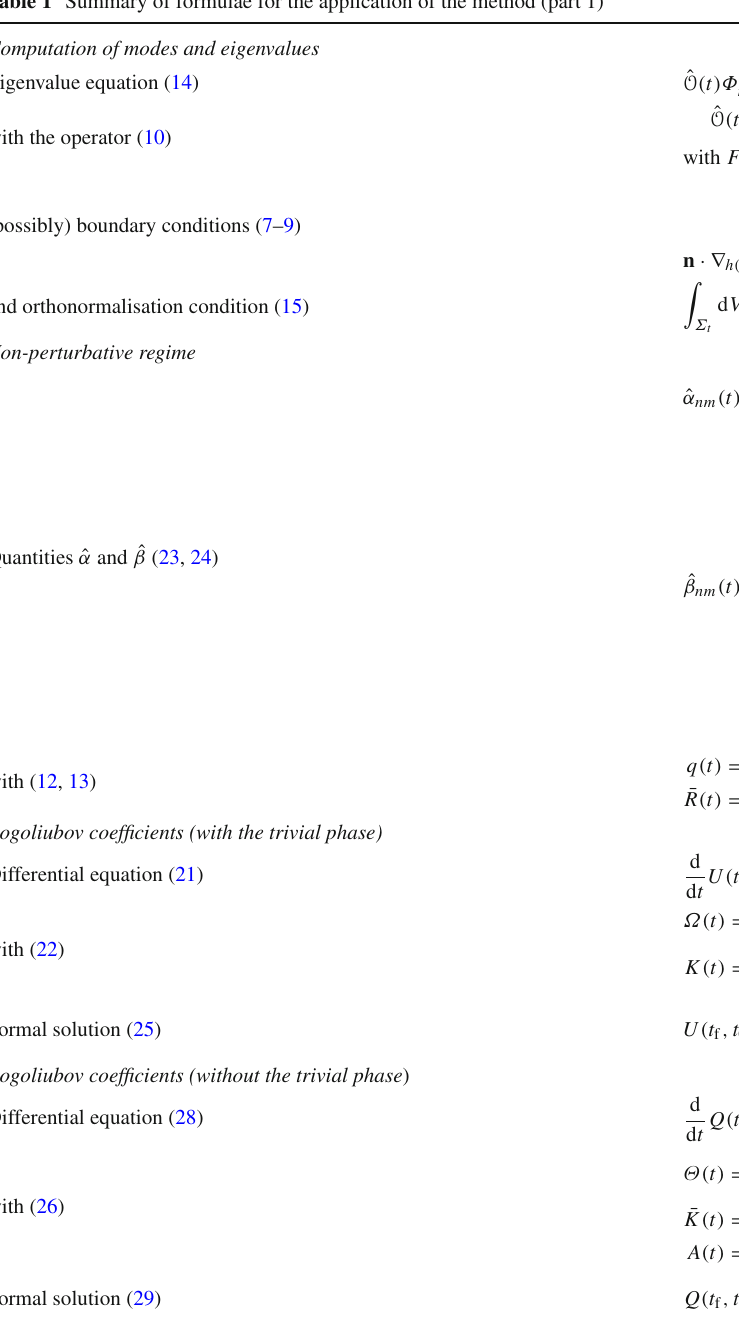
Table 1 Summary of formulae for the application of the method (part